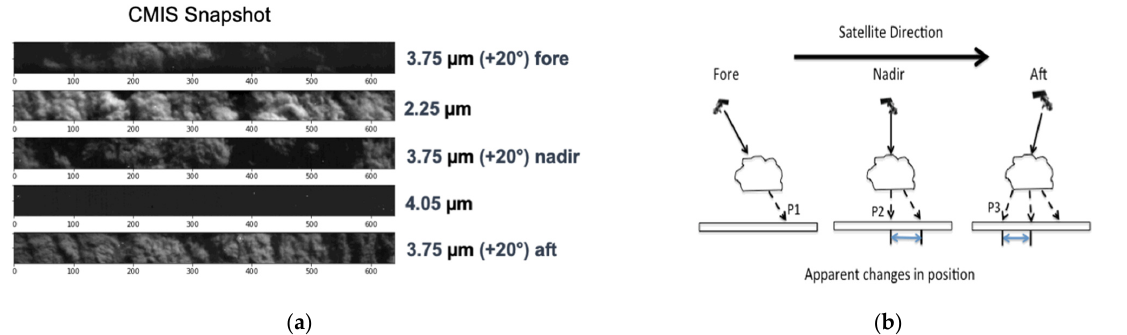
Figure 2. ( a ) Snapshot from CMIS engineering flight showing unprocessed counts resulting from the five-stripe filter. ( b ) Depiction of the fore, nadir, and aft views as the satellite (or aircraft) moves from right to left to derive apparent changes of position for clouds or terrain.